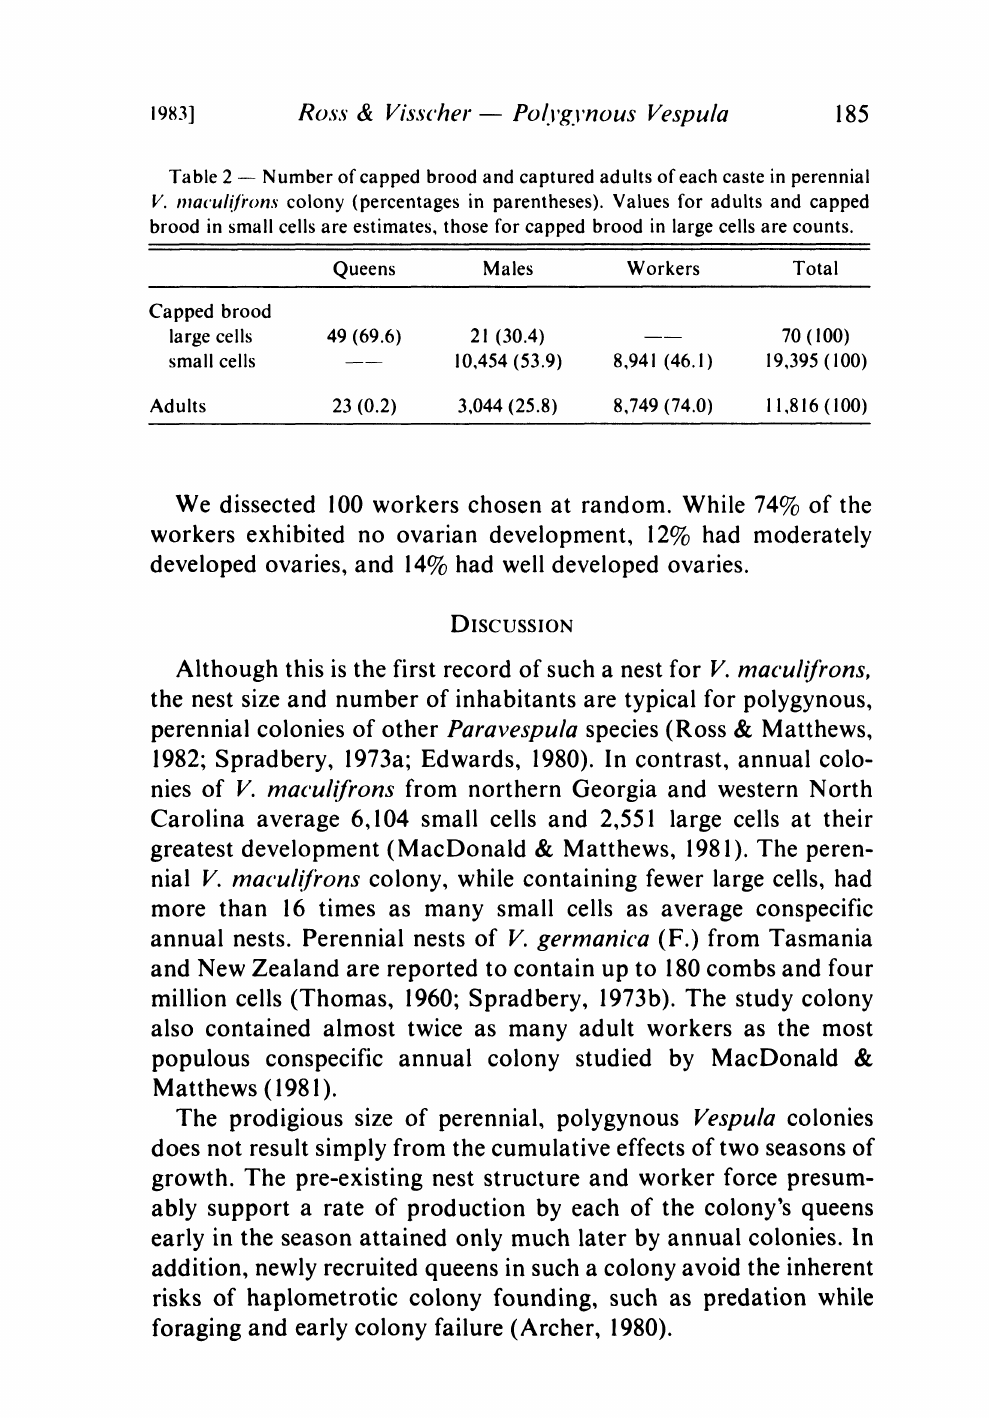
Number of capped brood and captured adults of each caste in perennial V. macui([’rons colony (percentages in parentheses). Values for adults and capped brood in small cells are estimates, those for capped brood in large cells are